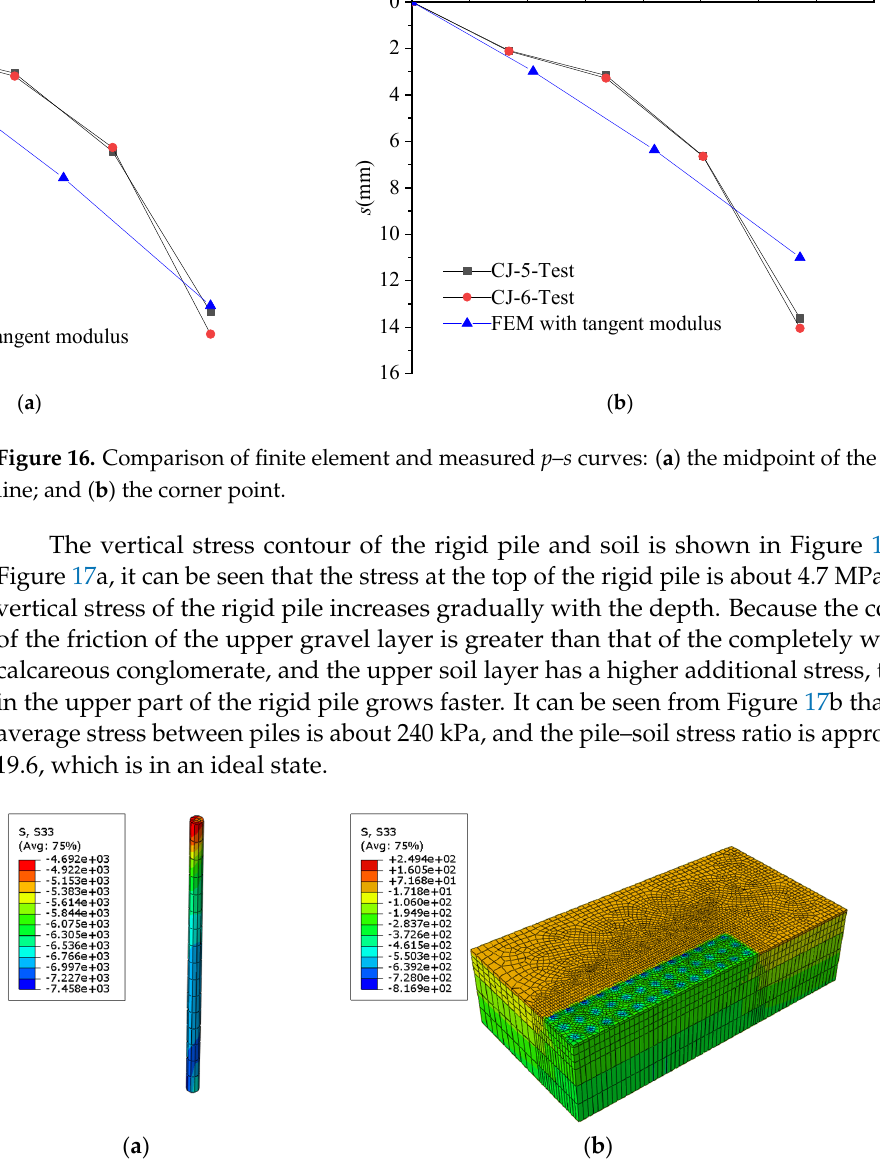
Figure 15. Vertical settlement contour of rigid pile composite foundation (m).